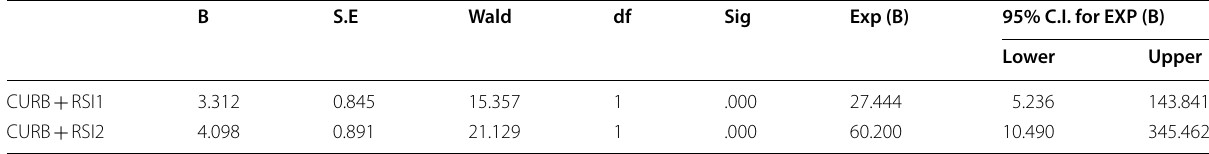
CURB RSI1 3.312 + CURB +